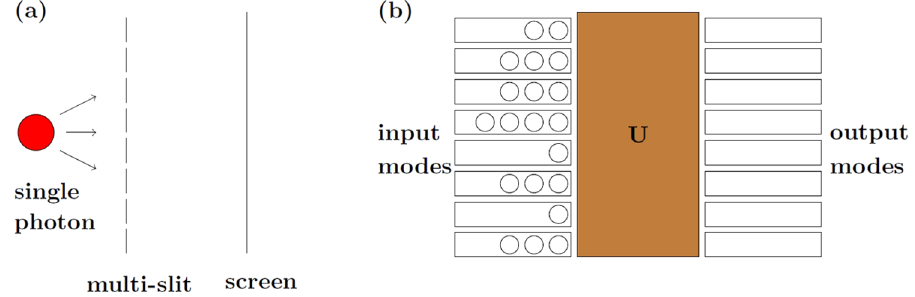
Figure 1. ( a ) A single photon that passes through a well-separated multi-slit. ( b ) Multi-photons injected to a multi-mode linear optical network system U